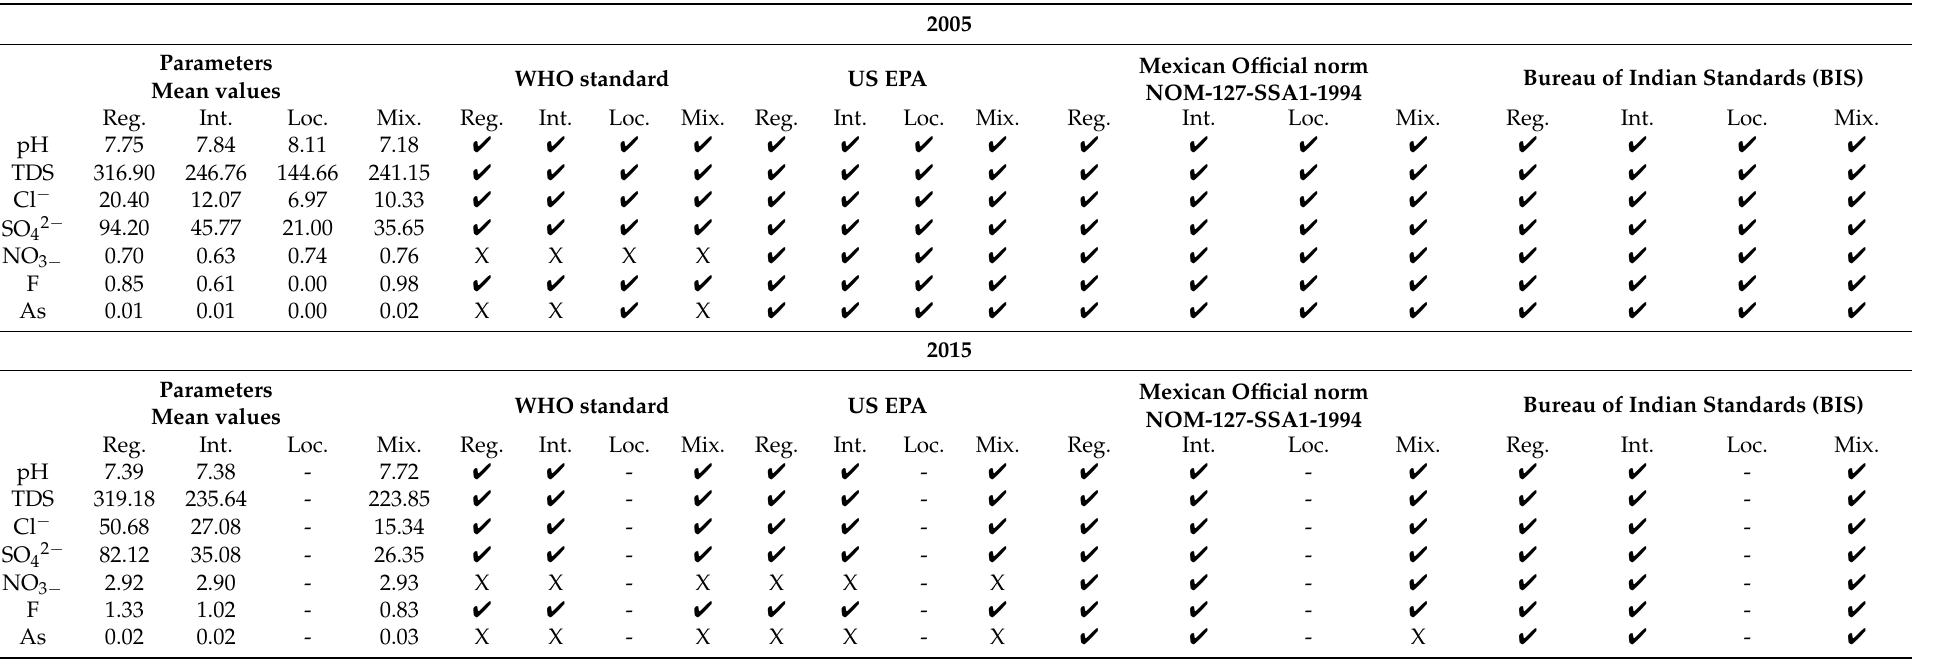
2005 Mexican Official norm Bureau of Indian Standards (BIS)